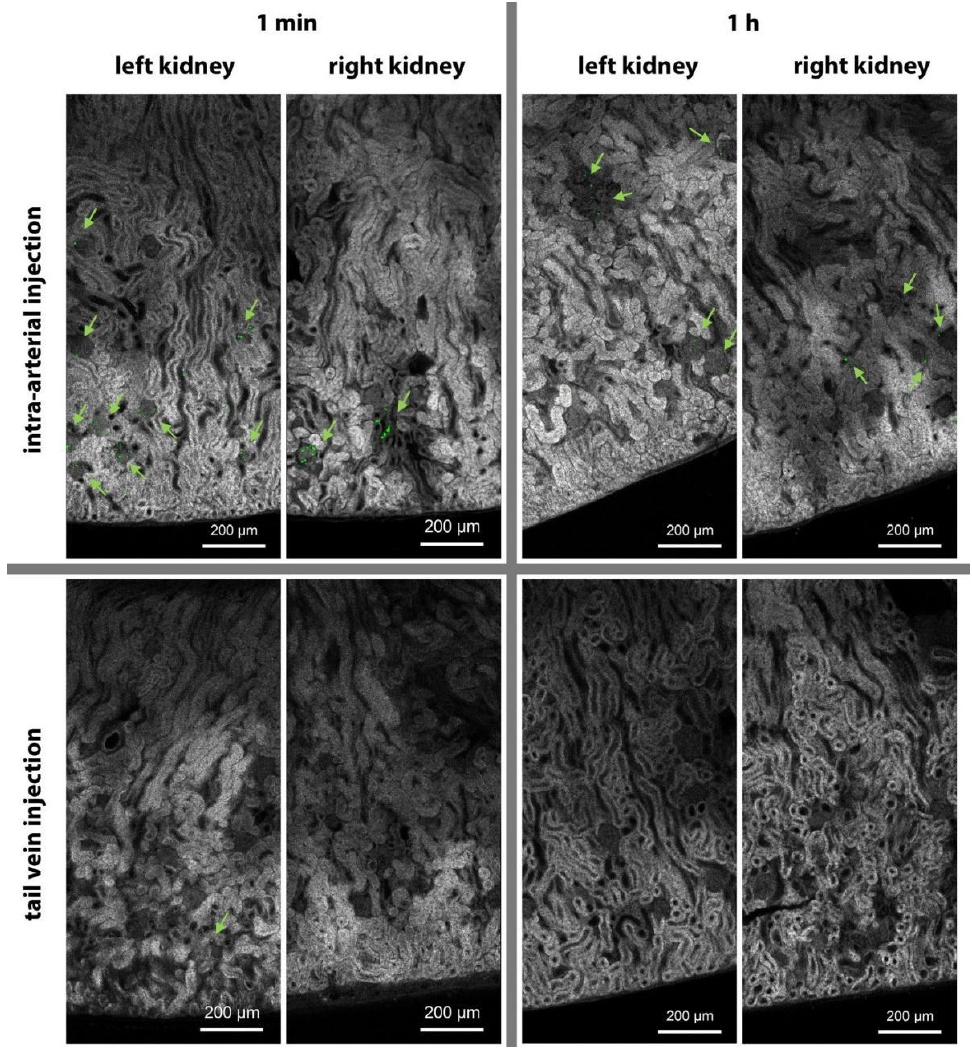
Figure 4. Results of 3D CLSM of kidney tissue cryosections (thickness 70 µ m) after 1 min and 1 h with different methods of administration. Maximum intensity projection of fluorescent signal of microcapsules containing etanercept and labeled with BSA-RITC (green, 514 nm excitation, 550 – 650 nm detection). One of the XY planes with kidney tissue autofluorescence (gray, 405 nm excitation, 420 – 500 nm detection), in which all structures of the kidney section are in the best focus.